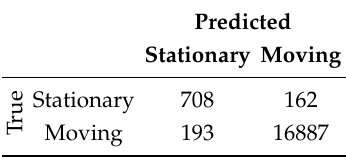
Table 7. Test set confusion matrix for stationarity detection.